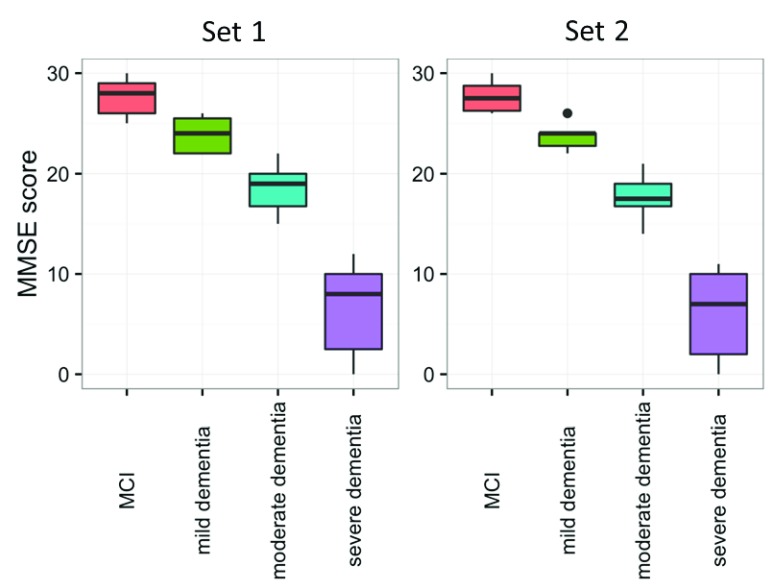
Distribution of cognitive test scores in mild cognitive impairment (MCI) and mild, moderate and severe Alzheimer’s disease (AD) dementia groups.The cognitive test Mini-Mental State Examination (MMSE) was compared between MCI, mild, moderate and severe AD dementia patients. A statistically significant difference in cognitive performance was observed among the four groups, in both sets (p<0.001). Horizontal lines represent medians. The number of patients per group is mentioned in
Table 1.